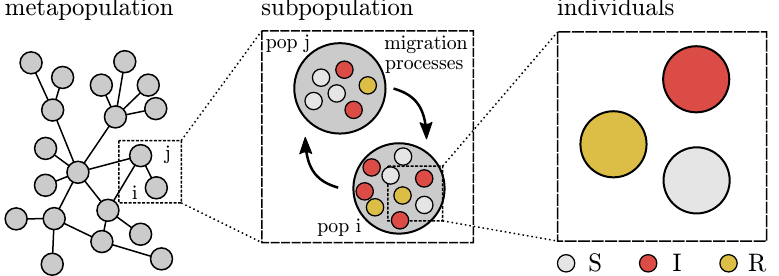
Figure 2. Schematic representation of a metapopulation model. The system is composed of a heterogeneous network of subpopulations or patches, connected by migration processes. Each patch contains a population of individuals who are characterized with respect to their stage of the disease (e.g., susceptible, infected, removed), and identified with a different color in the picture. Individuals can move from a subpopulation to another on the network of connections among subpopulations. (Taken from Colizza and Vespignani